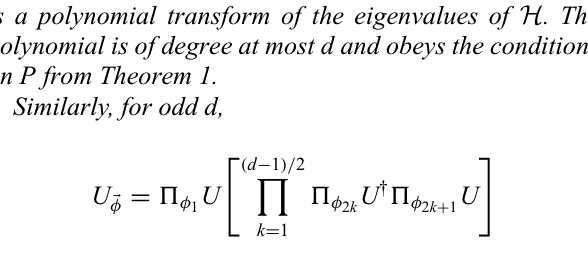
FIG. 3. The circuit used to realize the projector-controlled phase shift (cid:9) φ , also termed the “phased iterate,” in analogy to the bare exp ( i φ Z ) operation used in QSP, used as the signal- processing rotation